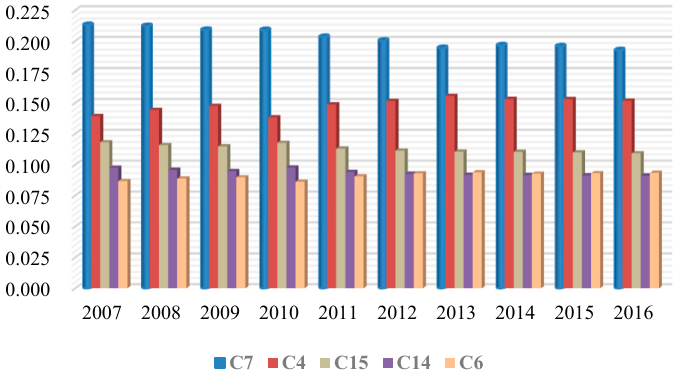
Figure 5. Di ff erence of the obstacle factors’ degree from 2007 to 2016.